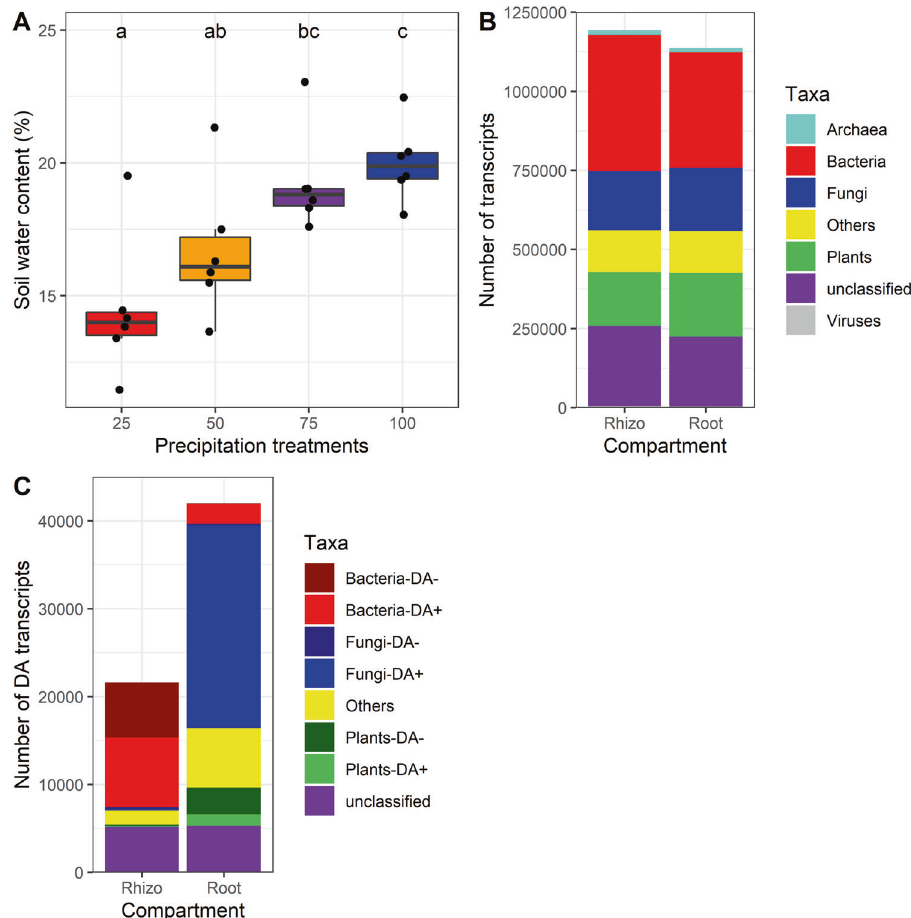
Fig. 1 Soil water content and kingdom-level af fi liation of transcripts. A Mean soil water content at the time of sampling for the four different precipitation manipulation treatments. B Kingdom-level taxonomic af fi liation of the transcripts retrieved for all roots and rhizosphere samples. C Kingdom-level af fi liation of the differentially abundant (DA) transcripts together with information if they were more or less abundant in the 25% treatment as compared to the 100%